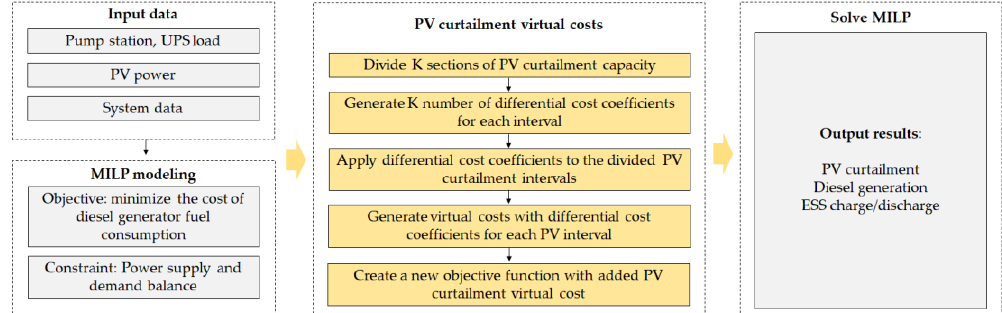
Figure 4. Flowchart of solving mixed-integer linear programming (MILP) with virtual PV curtailment gradation cost.